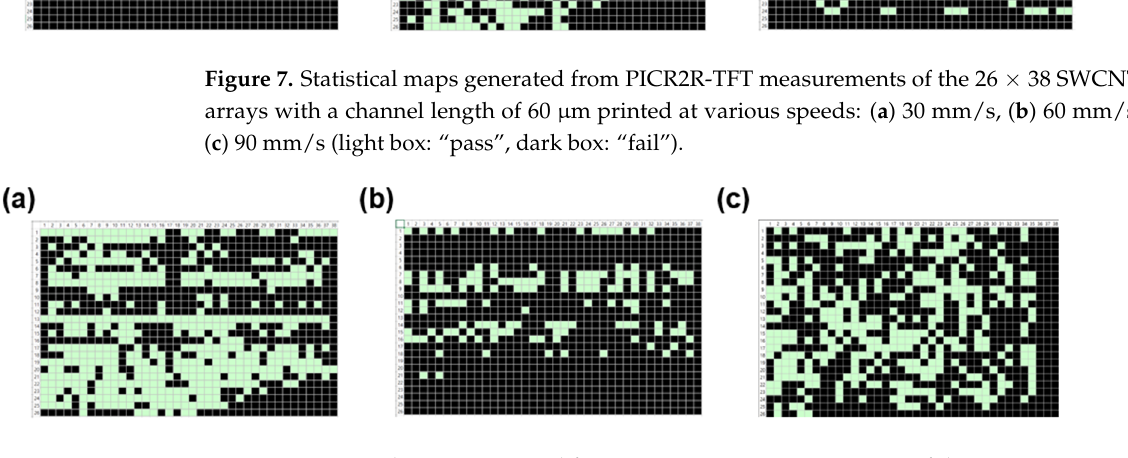
Figure 9. Statistical maps generated from PICR2R-TFT measurements of the 26 × 38 SWCNT-TFT arrays with a printing speed of 90 mm/s containing channel lengths of 60 µm at various lengths of a 6 m printing run: ( a ) 0 m, ( b ) 3 m, and ( c ) 6 m (light box: “pass”, dark box: “fail”). Figure 10. Relationship between device yield and printing conditions: ( a ) device yield depending on different printing speeds and ( b ) device yield depending on channel lengths. 4. Conclusions In this study, we developed a fast characterization tool, the PICR2R-TFT system, that can analyze an R2R-printed SWCNT-TFT array (26 × 38 = 988 TFTs). To demonstrate the capabilities of the PICR2R-TFT system, 26 × 38 SWCNT-TFT arrays were fabricated en- tirely using the R2R gravure printing process. Then, we were able to test the printed TFT